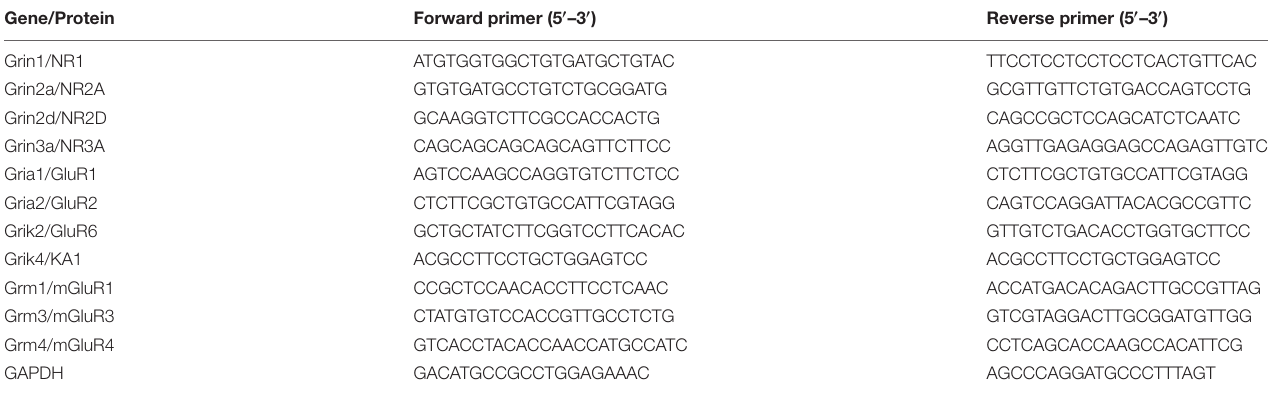
TABLE 1 | Primer sequence for real-time PCR. Gene/Protein Forward primer (5 (cid:48) –3 (cid:48) ) Reverse primer (5 (cid:48) –3 (cid:48)